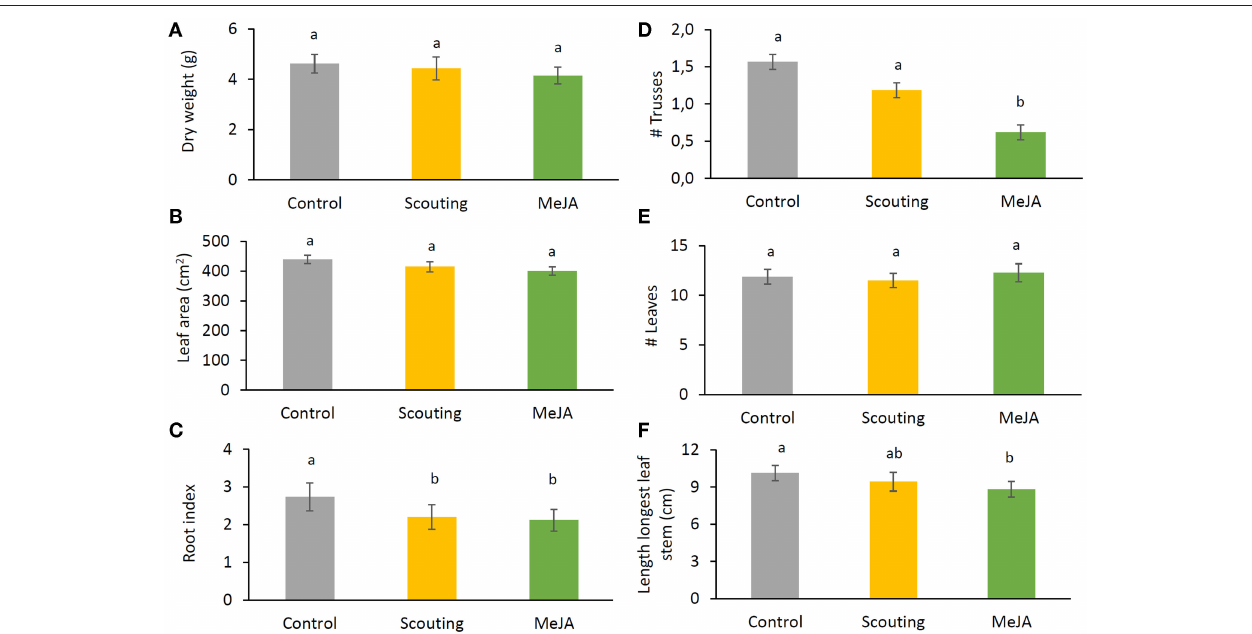
FIGURE 5 | Effect of MeJA treatment on plant growth and development traits at the end of the nursery phase of the strawberry cropping cycle. (A) The dry weight of aboveground plant parts; (B) total leaf area; (C) root index. Score of the amount of roots at the bottom of the rockwool block on a scale from 0 to 5; (D) number of trusses; (E) number of leaves; (F) length of the stem of the longest leaf. Data present mean ± SEM ( n = 10). Letters indicate significant differences between treatments at p ≤ 0.05 based on Kruskal–Wallis and subsequent pairwise comparisons using as Mann–Whitney U test.